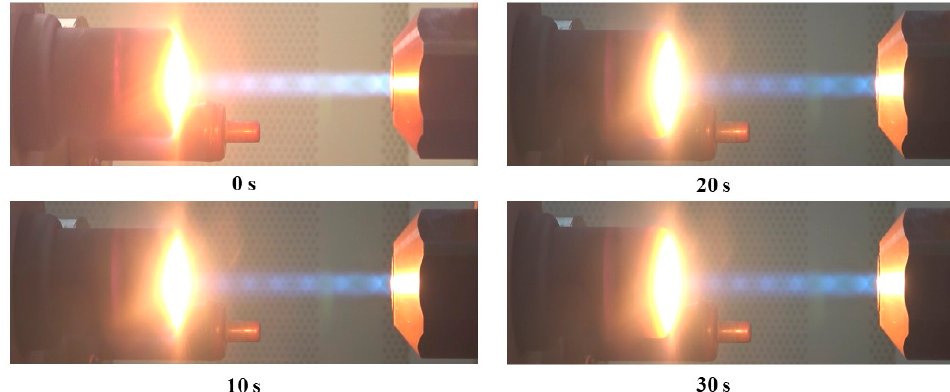
Figure 17. Camcorder images of the CP (30°)-4 specimen.